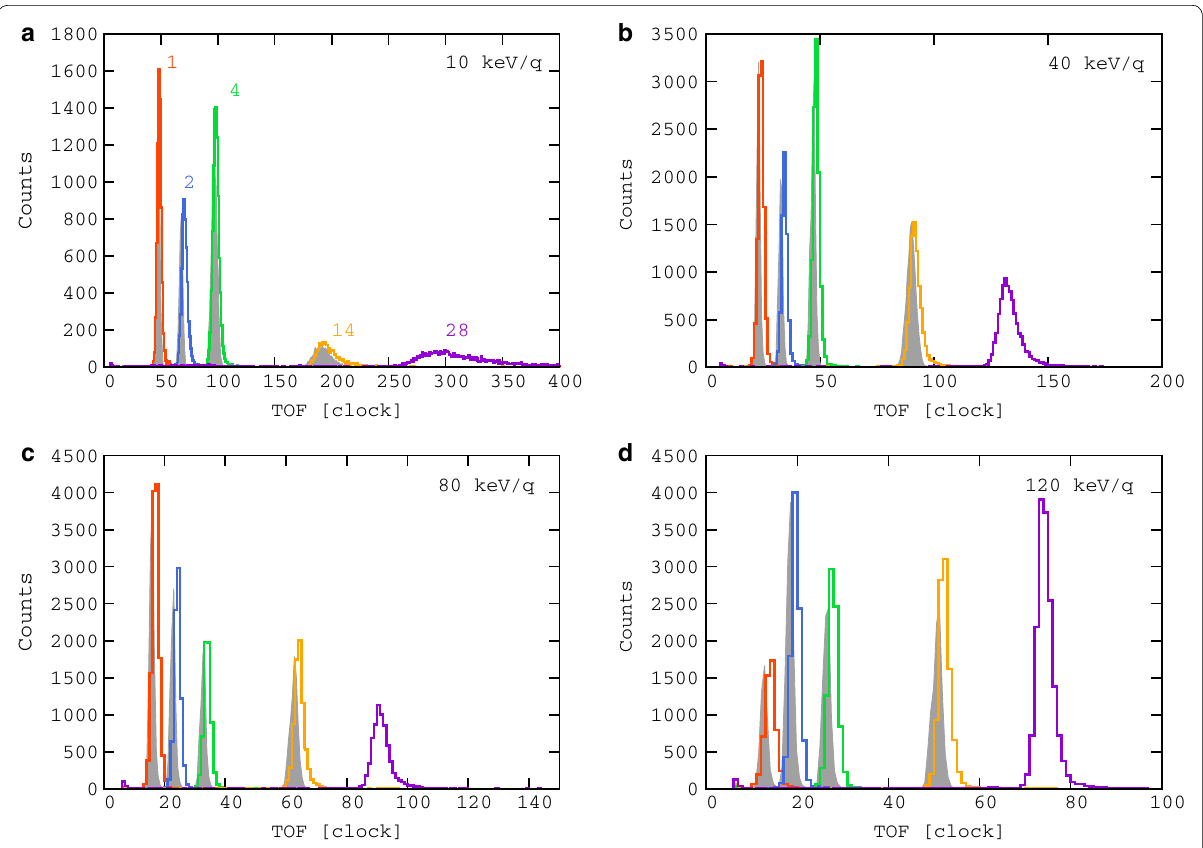
Fig. 9 TOF profiles of azimuthal channel 7 for a 10-keV/q, b 40-keV/q, c 80-keV/q, and d 120-keV/q beams of H + ( m/q ( m/q 4), N + ( m/q 14), and N 2 + ( m/q 28). The color histograms indicate the laboratory data, while the gray shades are the results of the = = = numerical simulations assuming the carbon foil thickness of 5 nm. The relative counts are not significant because they are dominantly due to the ion beam intensity. The MEP-i has 512 TOF bins, and the longest wind corresponds to 400 ns (0.78125